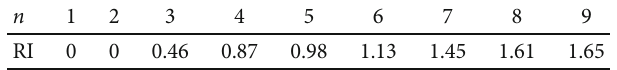
Table 2: Stochastic consistency indicator